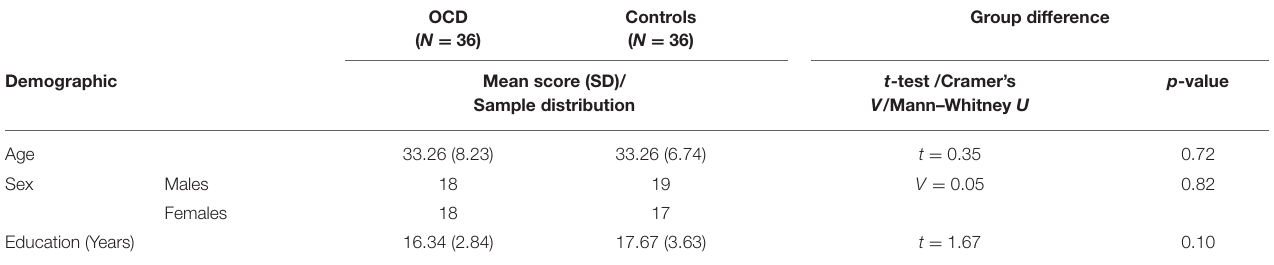
TABLE 1 | Summary table of demographic characteristics for individual age